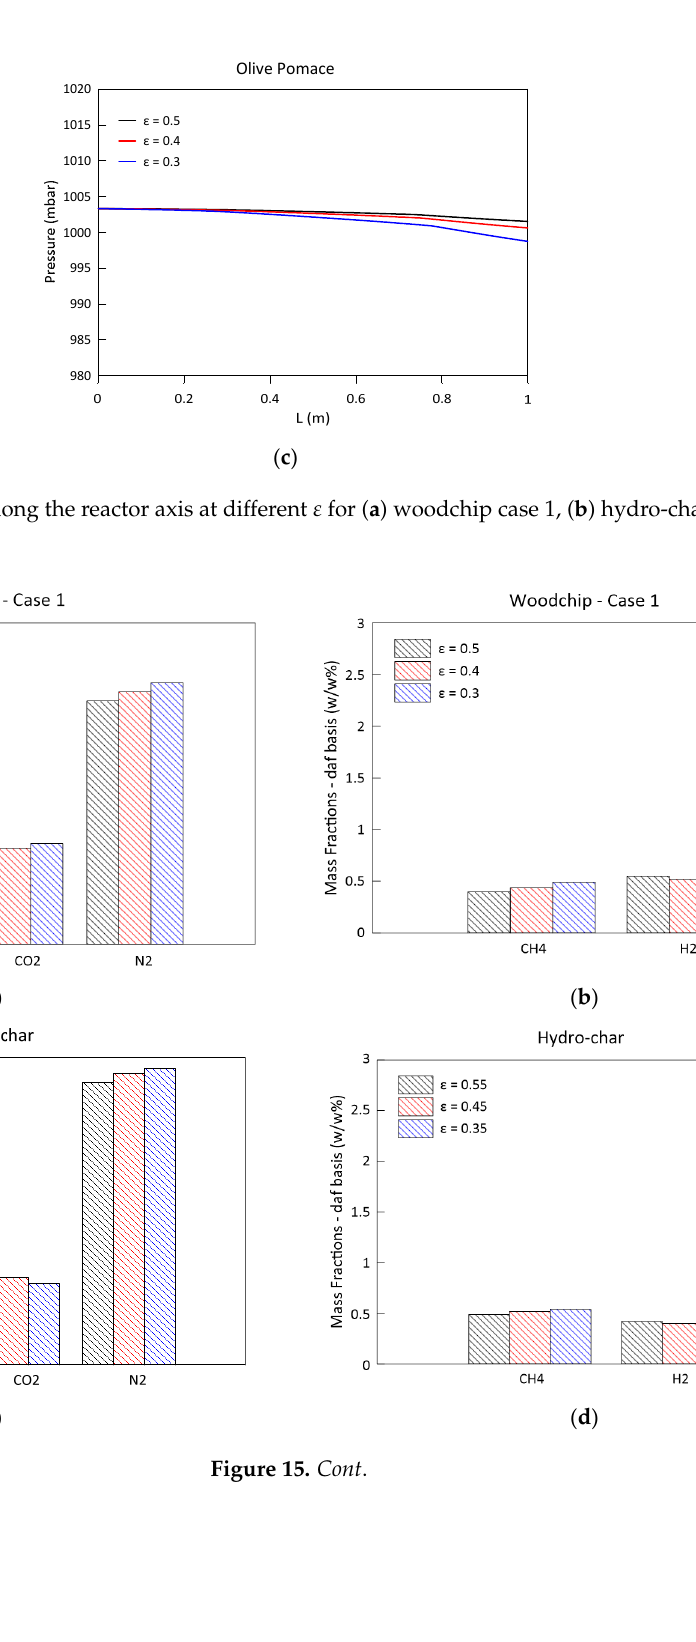
Figure 15. Species mass fractions (on a daf basis) at the reactor exit section, at different ε , for ( a , b ) woodchip case 1, ( c , d ) hydro-char from green waste, ( e , f ) olive pomace gasification.